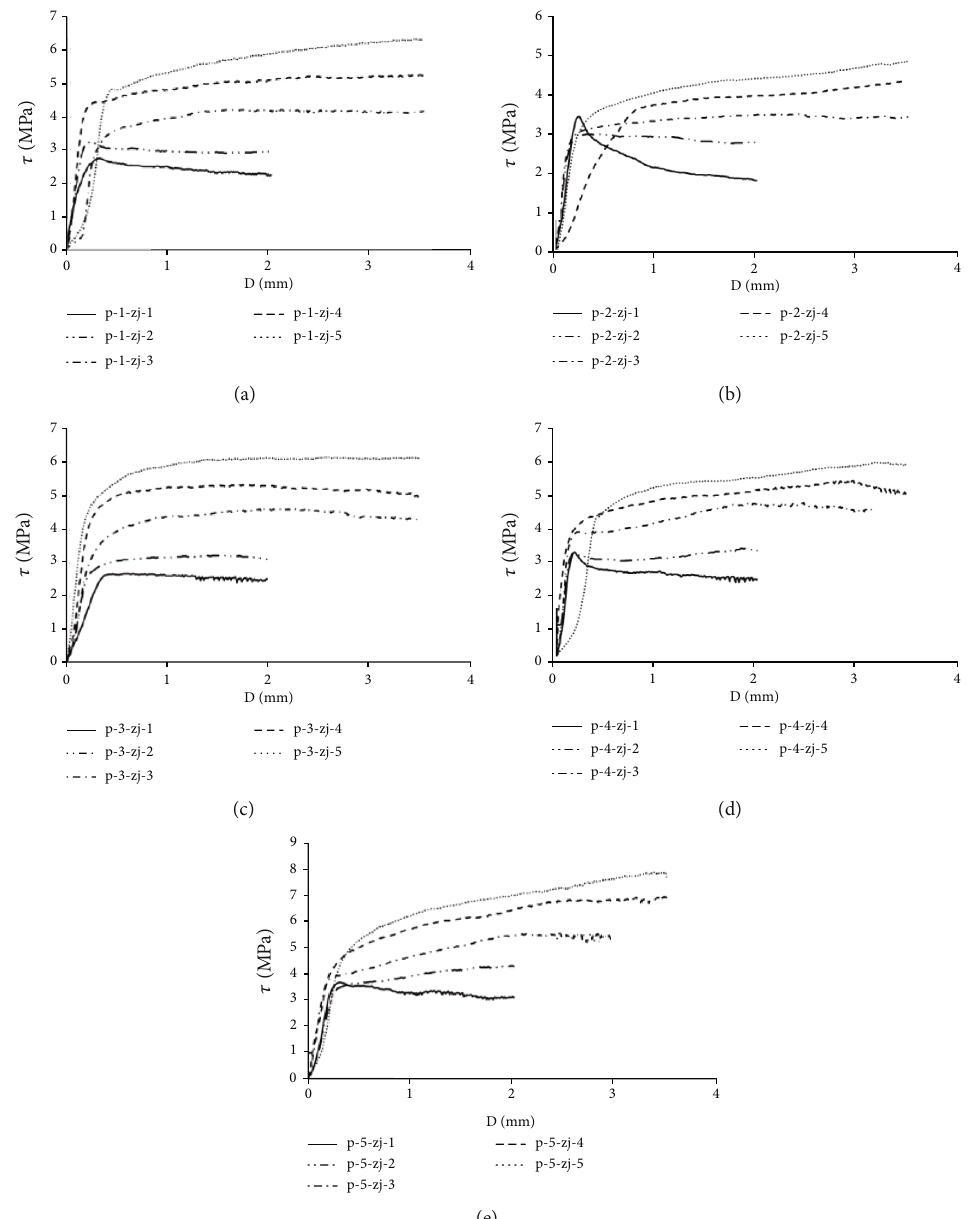
Figure 8: Direct shear stress-displacement curve (MPa mm) of discontinuities with 3D morphological properties under di ff erent normal forces. (a) p-1. (b) p-2. (c) p-3. (d) p-4. (e)